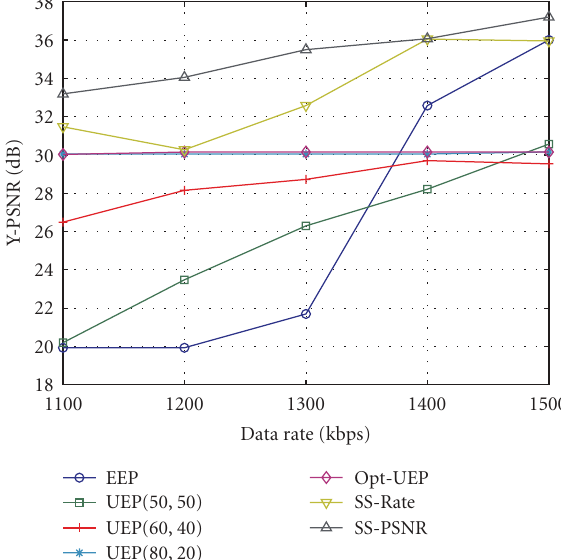
Figure 5: PSNR versus data rate at PLR of 10% for the “Paris” sequence—uniform